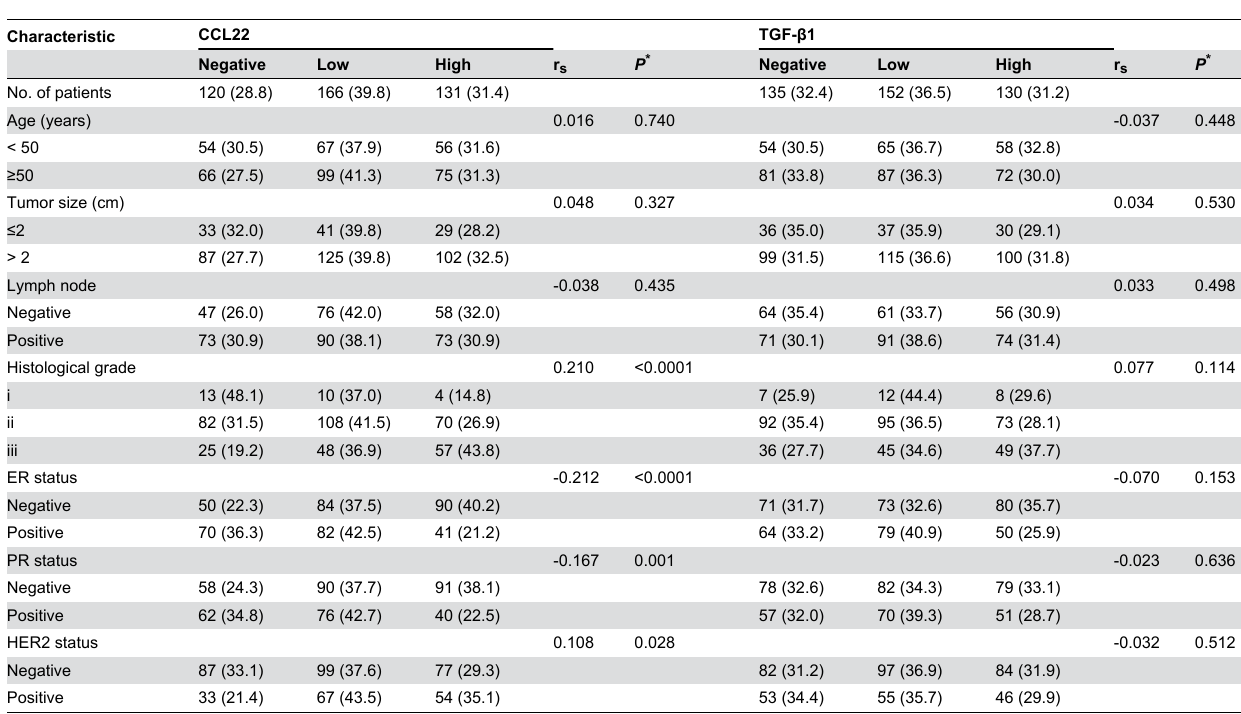
Table 3. CCL22 or TGF-β1 expression and pathological features of BC.